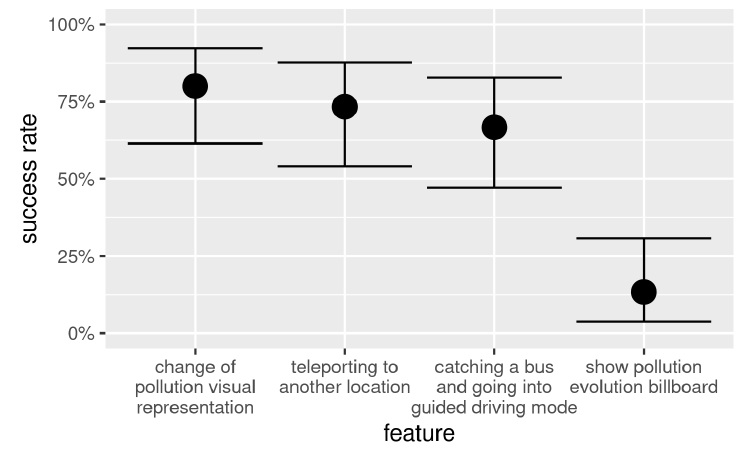
Figure 11. Plot of success rate in four main features of CityOnStats: Change of pollution visual representation, teleporting to another location, catching a bus and going into guided driving mode, and show pollution evolution billboard. Dots and error bars represent averages and 95% CI (binomial test),